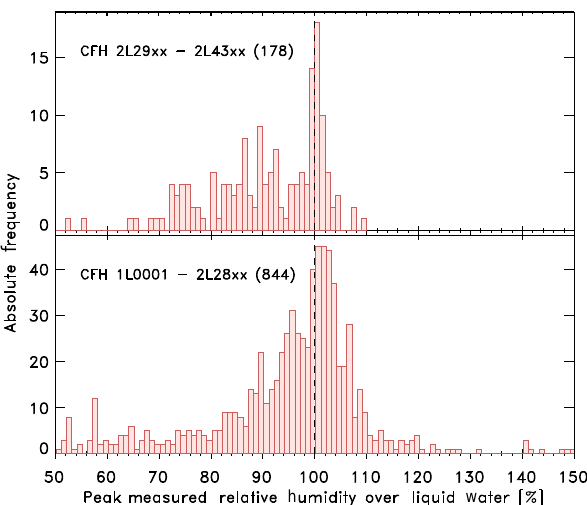
Figure 7. Frequency distribution of measured peak RH values in the lower troposphere. The bottom panel shows the distribution us- ing the CFH instrument through serial number 2L28xx. The up- per panel shows the current instrument series, which started with 2L29xx. Peak values above 100% are an indication for bias either in the temperature measurement or in the water vapor measurement. While some significant measurements of supersaturation were taken using instruments through 2L28xx, no significant supersaturation has been observed with instruments starting with 2L29xx.